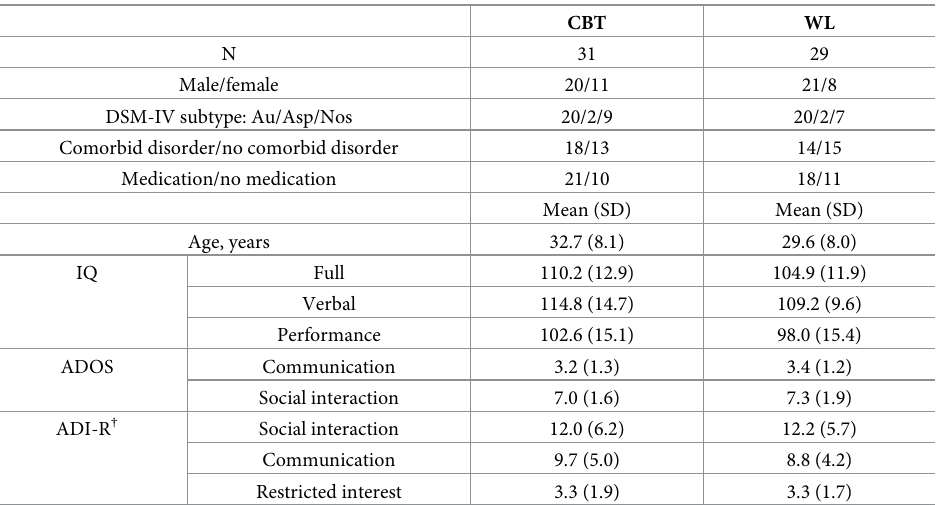
Table 2. Descriptive statistics of participant